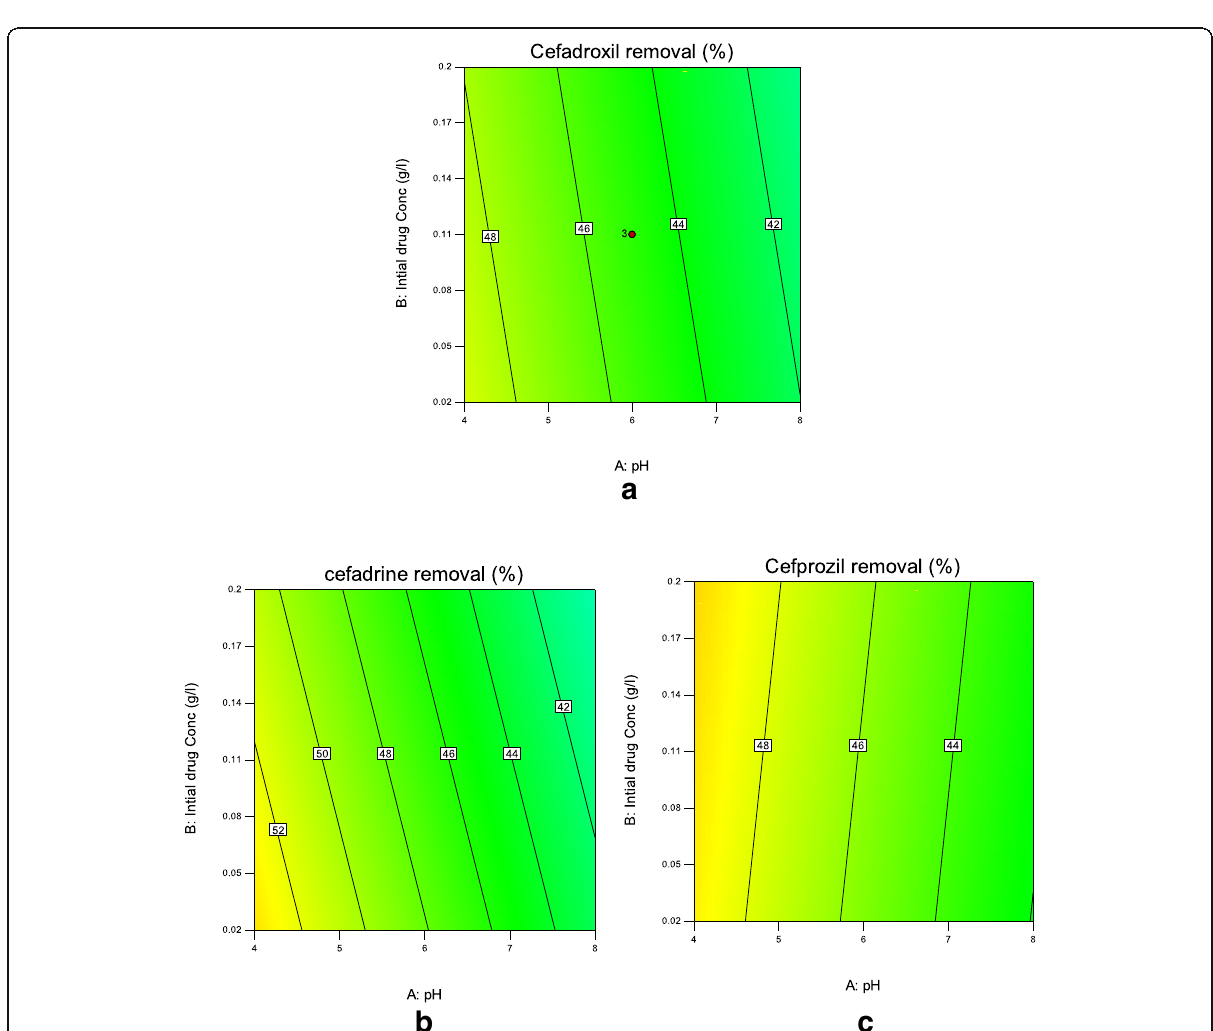
Fig. 3 Interaction of pH with an initial concentration of a cefadroxil, b cefprozil, and c cefradine at MSN loading dose 1